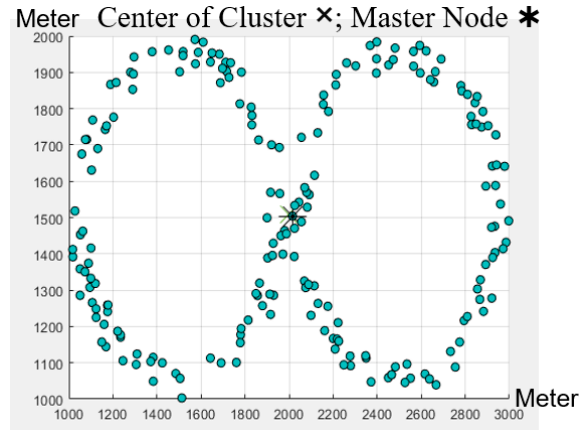
Figure 4. Single master election.